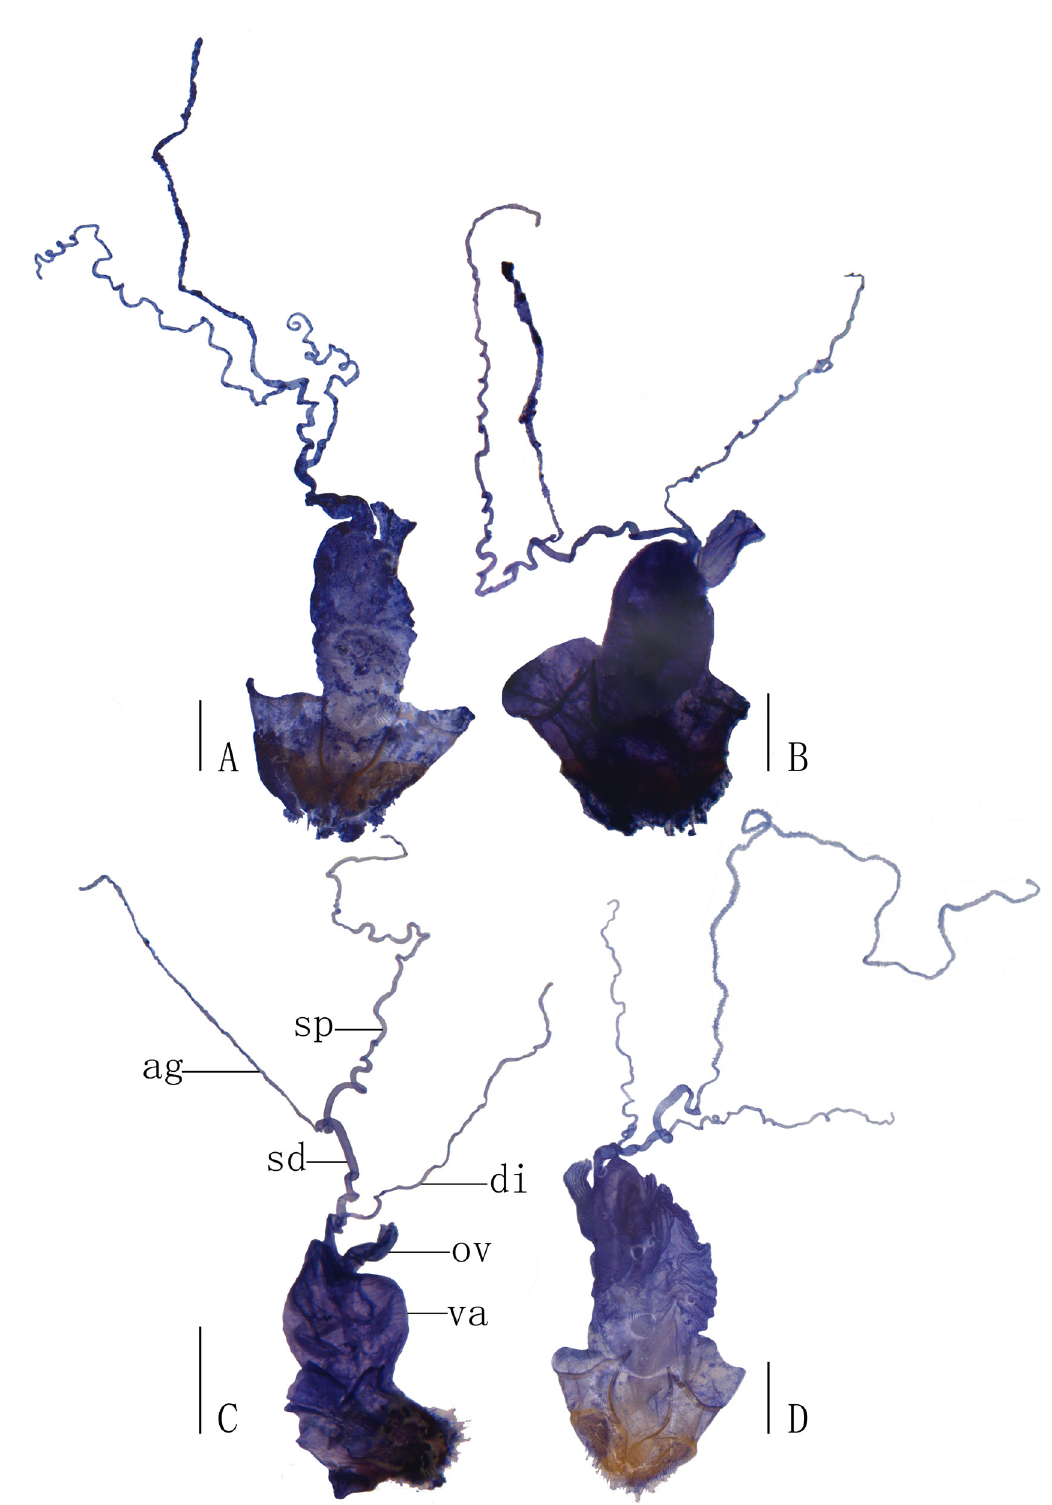
Fig. 8. Female reproductive system, ventral view. A . Stenothemus grahami Wittmer, 1974 (IZAS, Gansu). B . S . jindrai Švihla, 2004 (IZAS, Sichuan). C . S . minutissimus (Pic, 1933) comb. nov. (IZAS, Sichuan). D . S . tryznai Švihla, 2004 (IZAS, Sichuan). Abbreviations: see Material and methods. Scale bars = 0.5